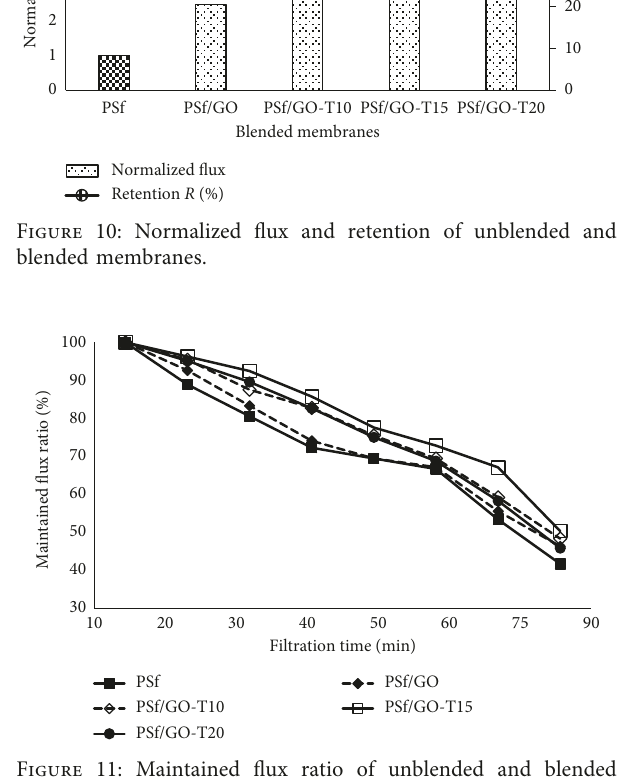
Figure 11: Maintained flux ratio of unblended and blended